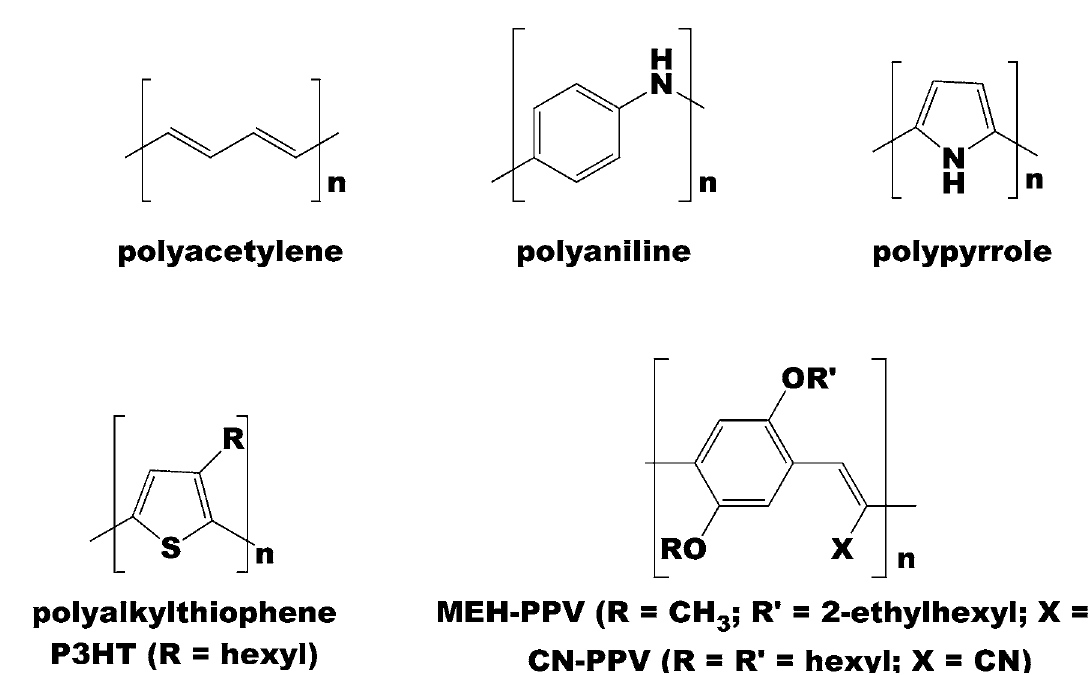
Figure 5. Chemical structures of some common conducting